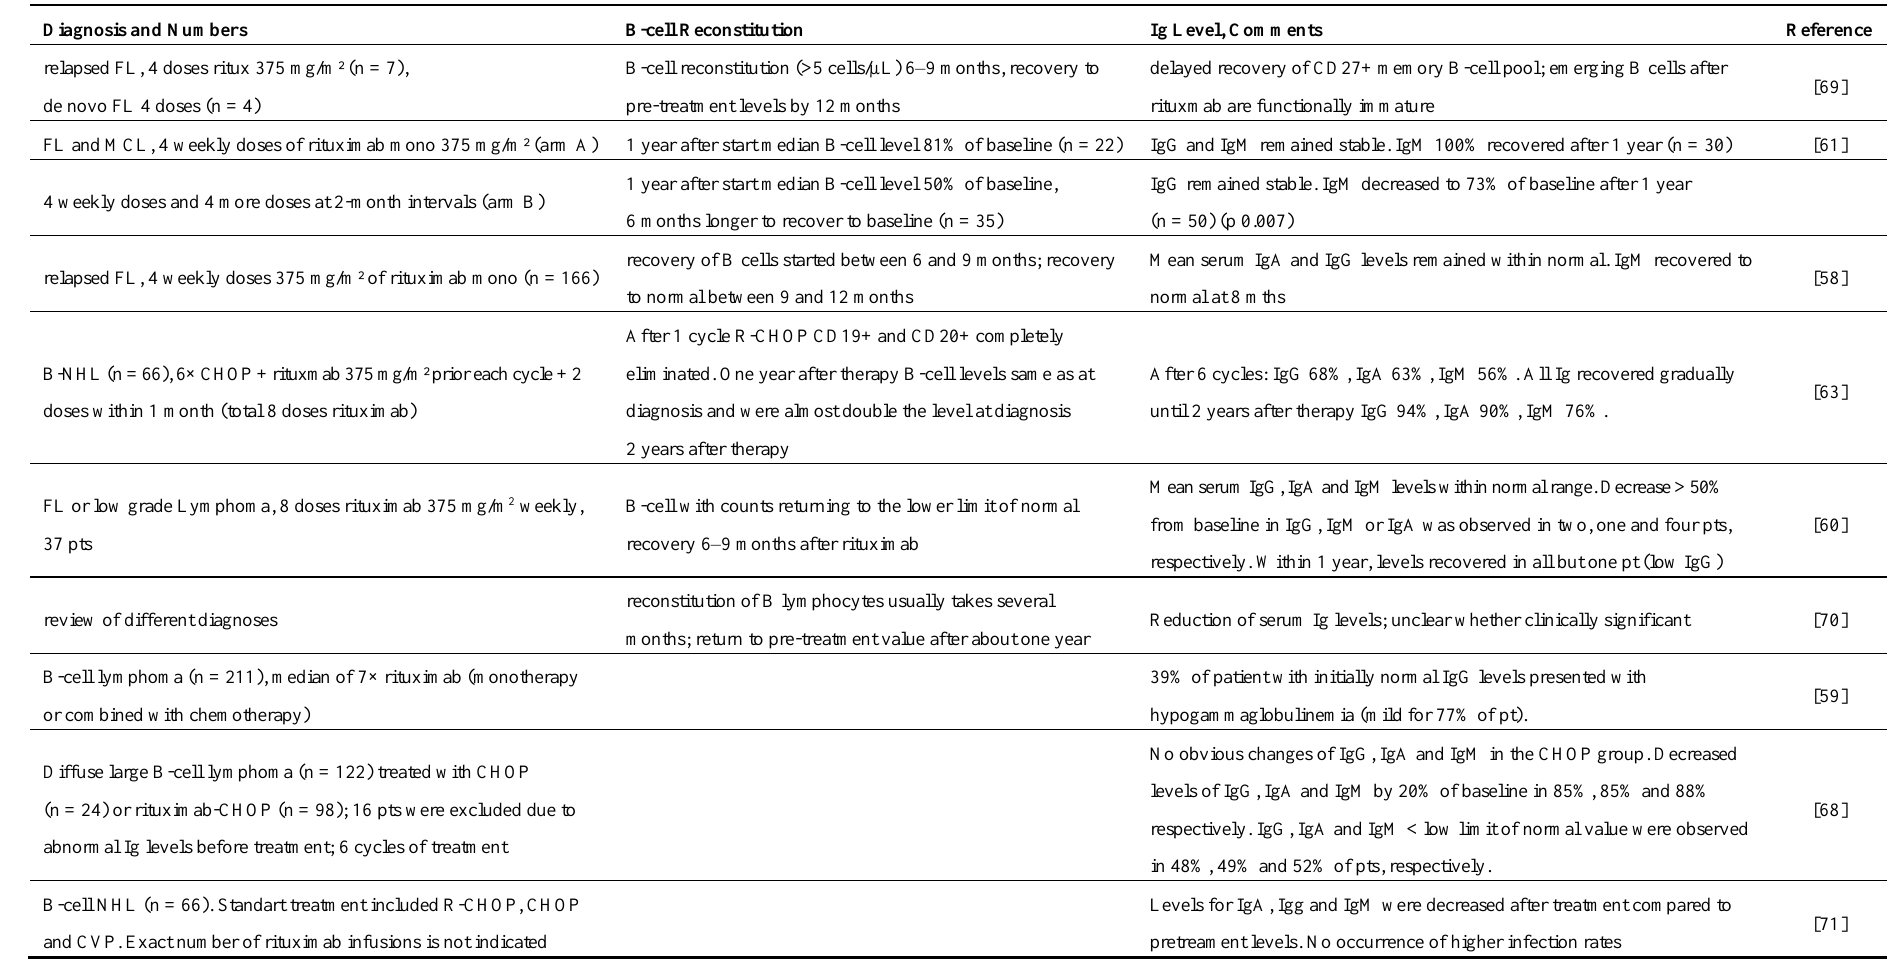
Table 2. Immunreconstitution in adult NHL patients after rituximab